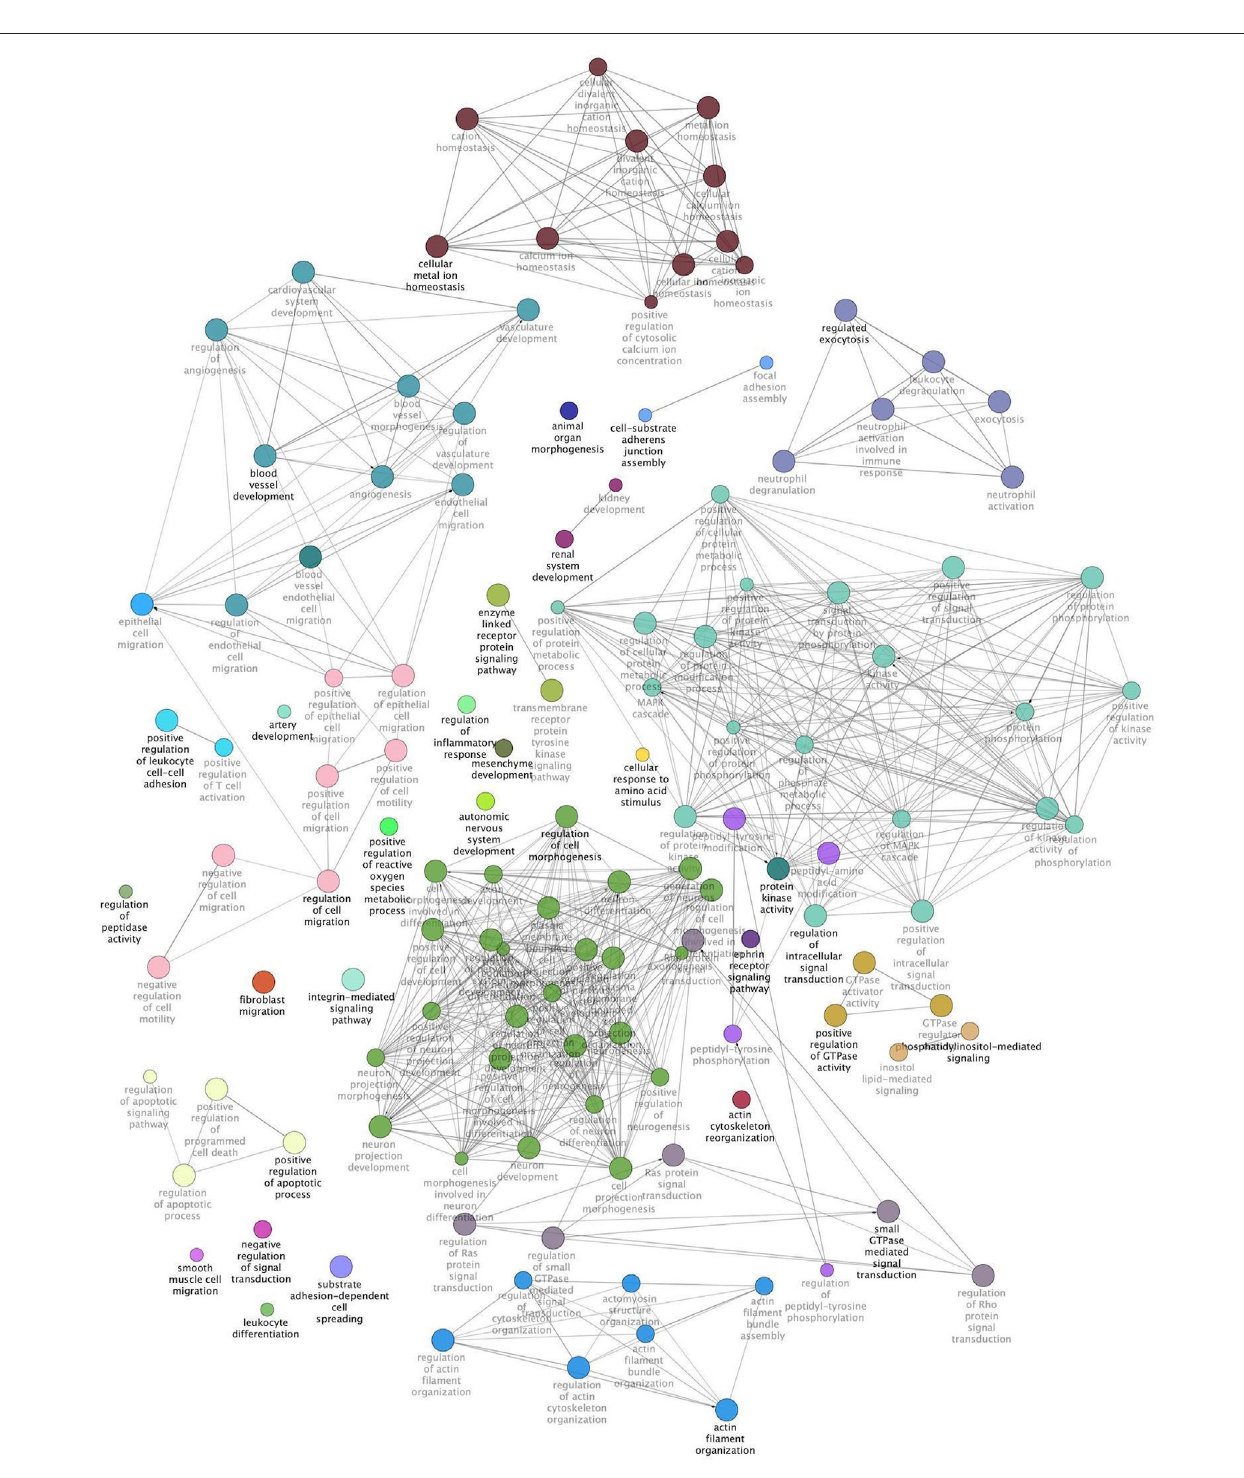
FIGURE 3 | Protein content module functional network. This image shows functional terms identi fi ed by ClueGO considering genes belonging to the protein content module and whose mRNA level covaried with the crude protein content in normal and White Striping/Wooden Breast affected Pectoralis major muscles in 52- day-old broilers. Connections show how functional categories interact with each other. Terms belonging to the same functional group are colored with the same color, while terms belonging to two different functional groups have both colors of groups they belong to. Black bold terms indicate the leading group term identi fi ed by the highest level of signi fi cance, using the Benjamini – Hochberg p -value and setting p < 0.05 as signi fi cant threshold.